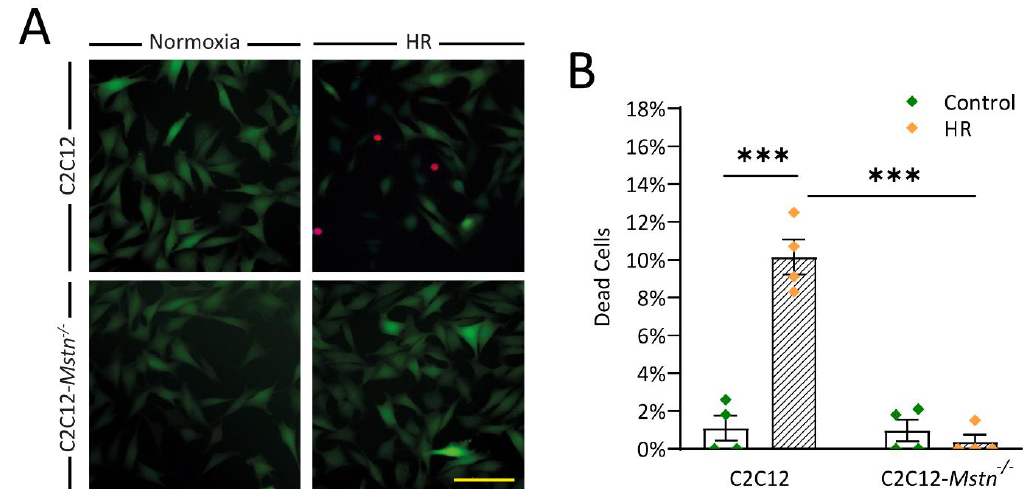
Figure 2. FDA/PI-Stain illustrates the better survival of C2C12- Mstn − / − cells when exposed to HR. ( A ) Representative images at 40 × magnification displaying viable cells and dead cells under normoxic (left panels) and HR (right panels) conditions. ( B ) Graph depicting the percentual number of dead cells (Fluorescein Diacetate/Propidium Iodide stain) in C2C12 and C2C12- Mstn − / − cells under normoxic conditions and after HR. C, control cells incubated under normoxia. HR, cells incubated under hypoxic conditions for 4 h followed by normoxia for 15 min. For each graph, four independent experiments per group were conducted. Scale bar = 50 µ m. Results are shown as means ± SEM. p -value: *** < 0.001; ANOVA followed by a multiple test comparison via Tukey’s post-hoc test (homoscedasticity) or Brown–Forsythe and Welch ANOVA followed by Dunnett’s T3 post-hoc test (heteroscedasticity).